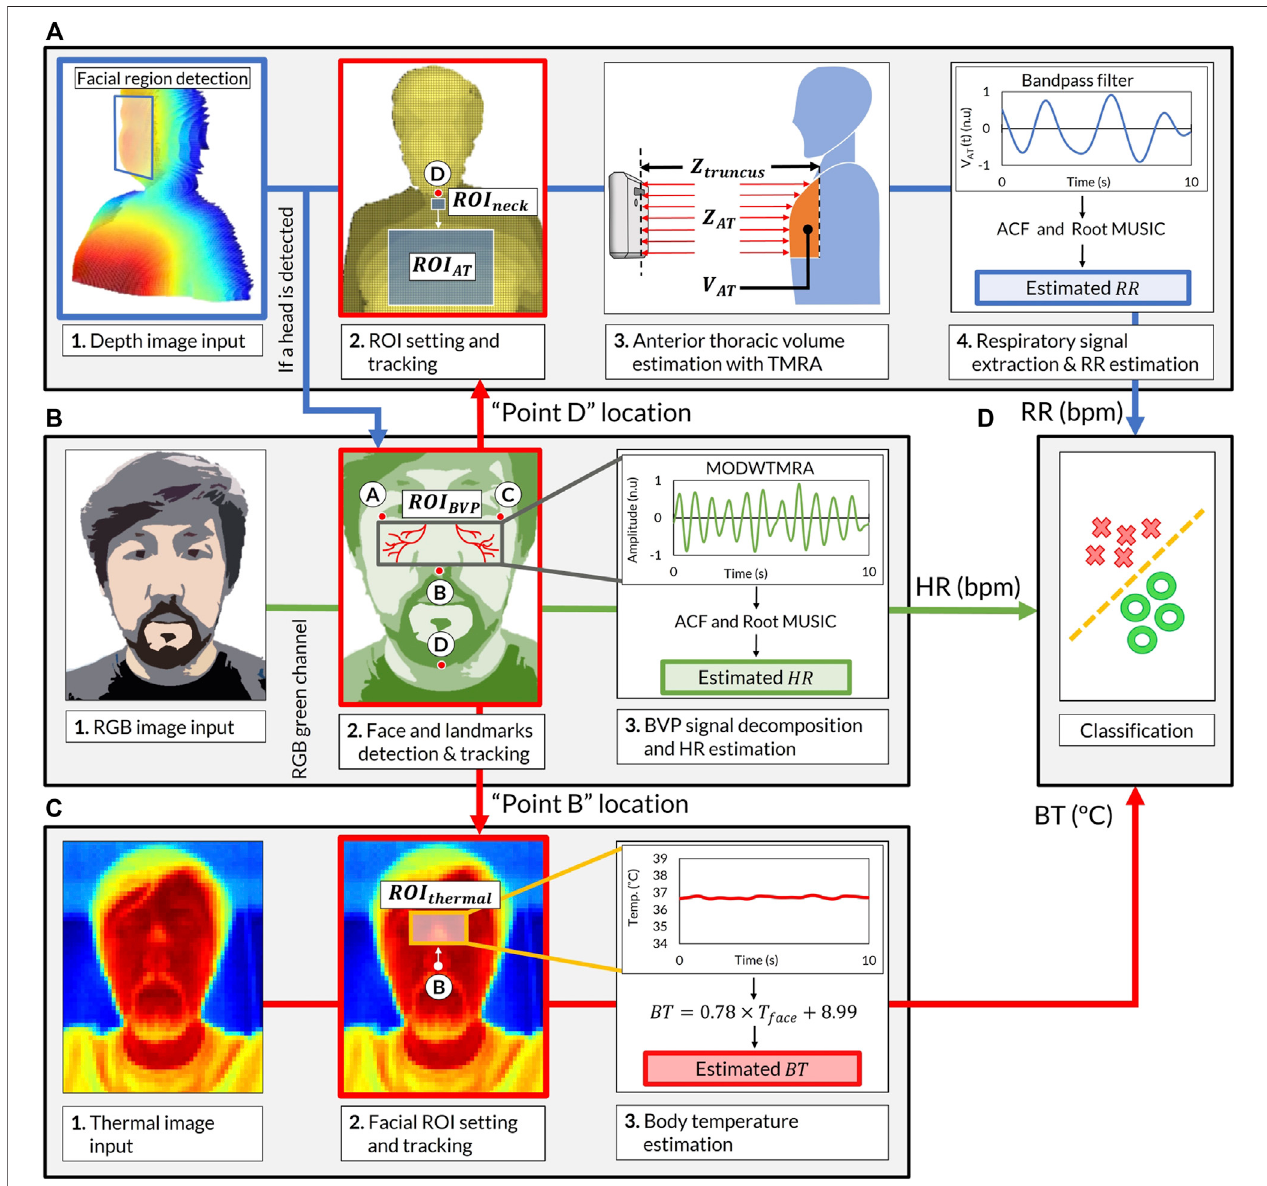
FIGURE 3 | Software block diagram of the VISC-Camera screening procedure. (A) Respiratory rate (RR) estimation procedure. (Chart 1) Stereo depth camera capture [424 × 240 pixels, 30 (frames/s)]. (Chart 2) ROI neck (3 × 3 cm) for truncus-motion monitoring is placed below point D. ROI AT [20 (H) cm ×18 (W) cm] for anterior thorax measurement is fi xed 12 cm below the D. (Chart 3) Estimation of anterior thoracic volume, V AT ( t ) , using truncus motion removal algorithm (TMRA), which separates non-respiratory truncus-motion [ Z truncus ( t ) ] from respiratory induced anterior thorax-motion [ Z AT ( t ) ]. (Chart 4) Extraction of the respiratory signal using autocorrelation function (ACF) and root MUSIC algorithm. (B) Heart rate (HR) estimation procedure. (Chart 1) RGB camera capture [424 × 240 pixels, 30 (frames/s)]. (Chart2) ROI BVP forHRmonitoringisdeterminedbyfaciallandmarksA-C.(Chart3)Heartbeatsignalobtainedbywavelettransformation(MODWTMRA)androotMUSIC algorithm. (C) Bodytemperature(BT)estimationprocedure.(Chart1)Thermalcameracapture(80×60pixels,9[frames/s]).(Chart2) ROI thermal (5×7 cm)isplaced3 cm above the landmark point B. (Chart 3) BT determined by the estimated equation from facial temperature. (D) Classi fi cation of patients with COVID-19 infections from healthyvolunteersusingexplanatoryvariablesofRR,HR,andBTvialogisticregressionanalysis.ROI,regionofinterest;MUSIC,multiplesignalclassi fi cation;BVP,blood volume pulse; MODWTMRA, multiresolution analysis of the maximal overlap discrete wavelet transform. determined using A to C, and ROI neck (3 × 3 cm) was placed below point D corresponding to the jaw. ROI thermal (5 × 7 cm) was placed 3 cm above B. Using typical human facial dimensions, ROI AT [20 (H) cm ×18(W) cm] was fi xed 12 cm below D (Bellemare et al., 2003).